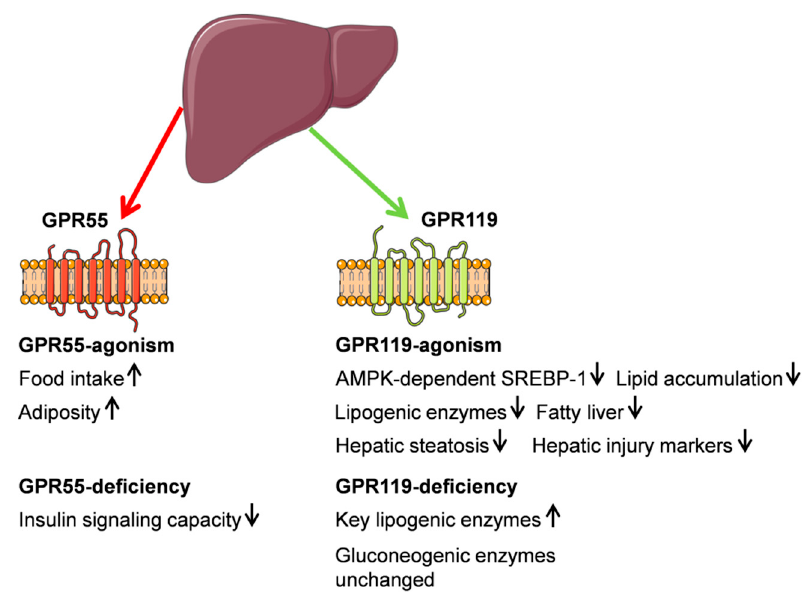
Figure 2. Schematic illustration of G protein-coupled receptor (GPR) function in liver metabolism. ( ↑ ) and ( ↓ ) define up or down regulation. Most findings were generated in rodent models. This figure was prepared using a template on the Servier Medical Art website (Available at: http://smart.servier.com/).